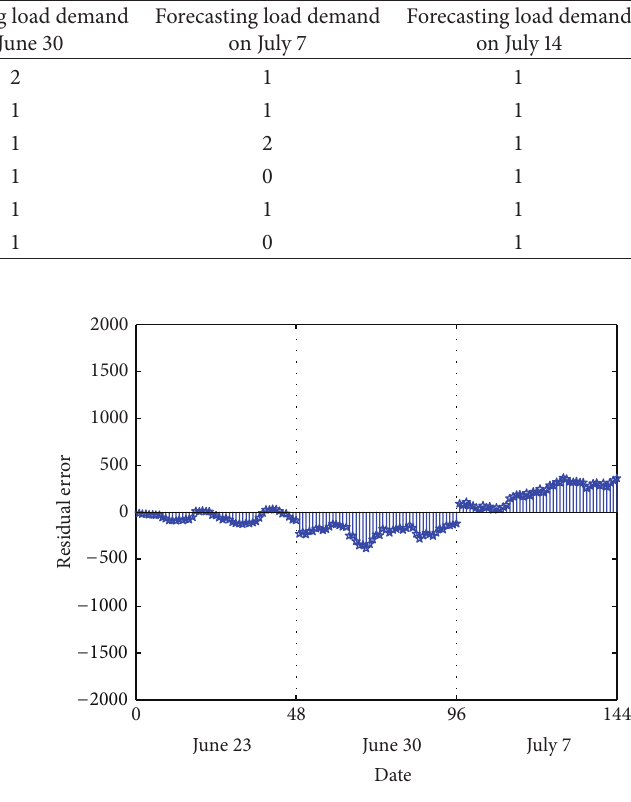
Figure 5: Residual error of the load demand forecasted by the seasonal ARIMA